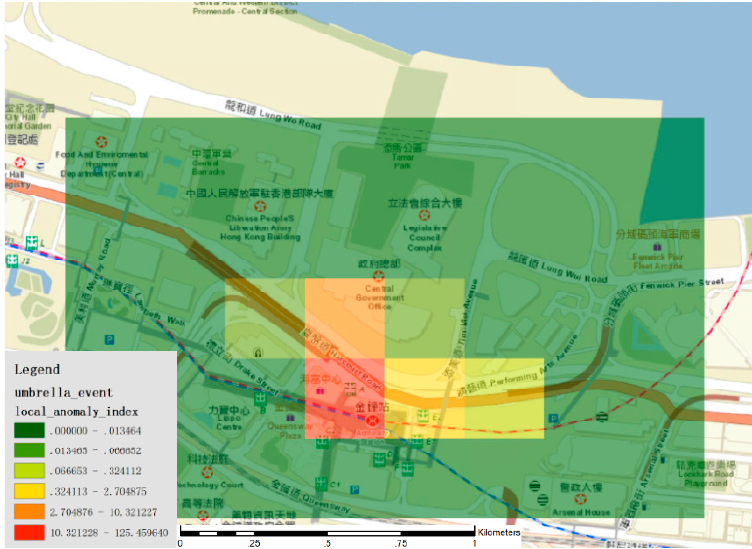
Figure 6. The Admiralty region, which shows high 𝐿𝐸𝐼 values for ’Umbrella Movement’ check-ins, indicating significant human aggregation in that region and the regions nearby.